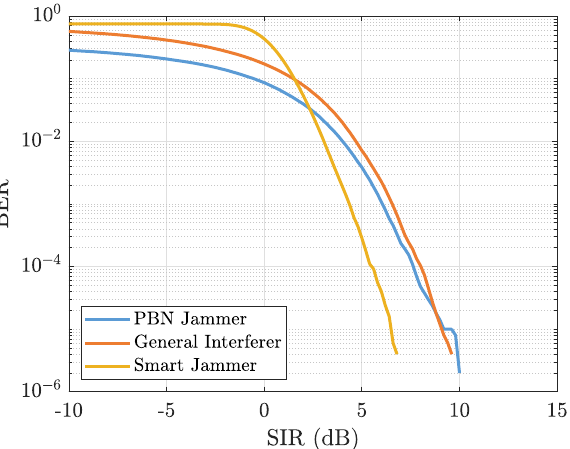
Figure 12. Comparison of BER as a function of the SIR for different types of interferers, 4–PSK modulation, and SNR = 15 dB.